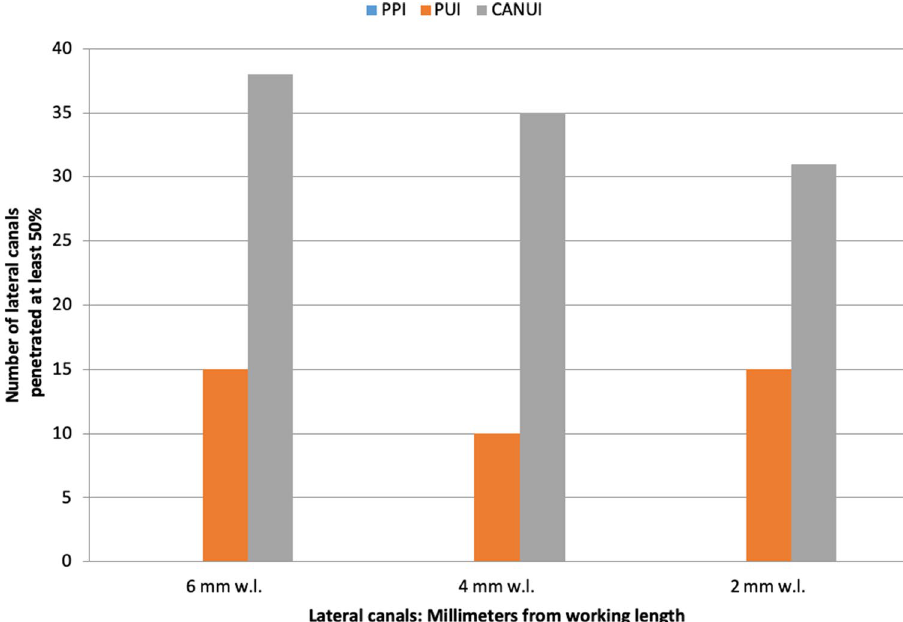
Figure 9. Graphical representation of straight root canals penetrated by the irrigation solution.